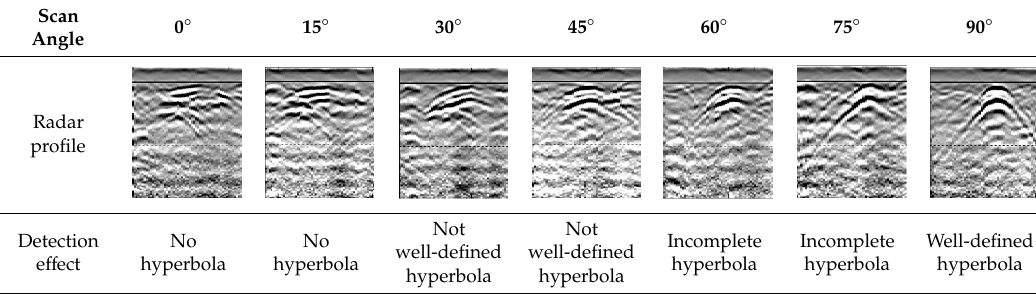
Table 2. Radar profiles of di ff erent survey line directions. Table 2. Radar profiles of different survey line directions. Table 2. Radar profiles of different survey line directions. Table 2. Radar profiles of different survey line Table 2. Radar profiles of different survey line directions. Table 2. Radar profiles of different survey line directions. Table 2. Radar profiles of different survey line directions. Table 2. Radar profiles of different survey line directions. Table 2. Radar profiles of different survey line directions.